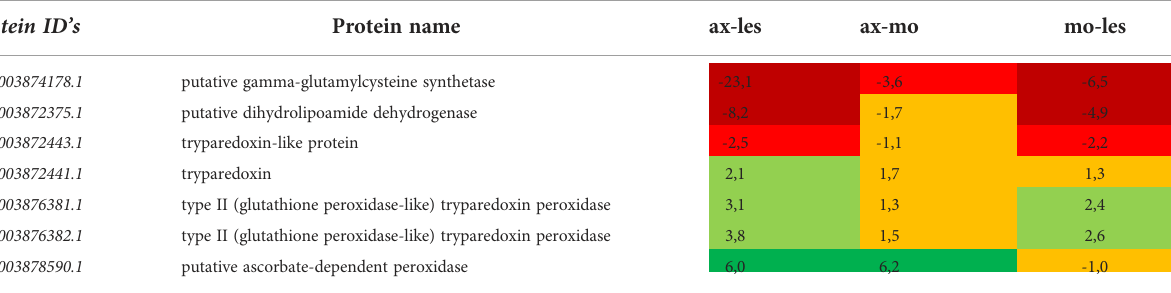
TABLE 6 Oxidative stress response enzymes identi fi ed in all 3 comparisons that differ by at least 2-fold (T-test signi fi cant) between individual amastigote types. Oxidative stress